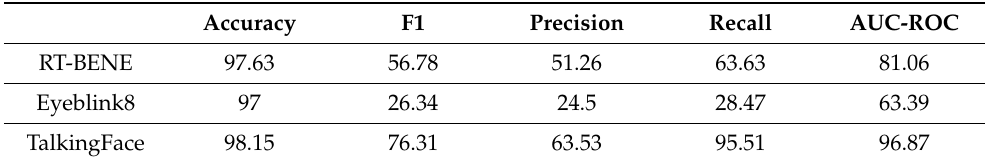
Table 3. Results for eyelid distance with adaptive threshold.